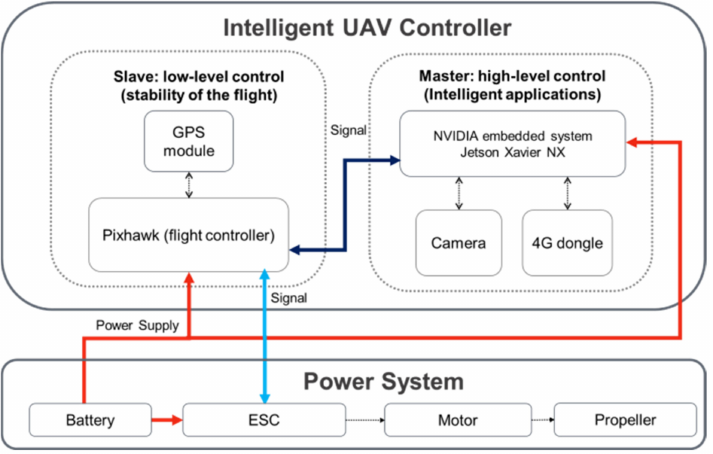
Figure 2. The layout of the unmanned aerial vehicle (UAV) system.